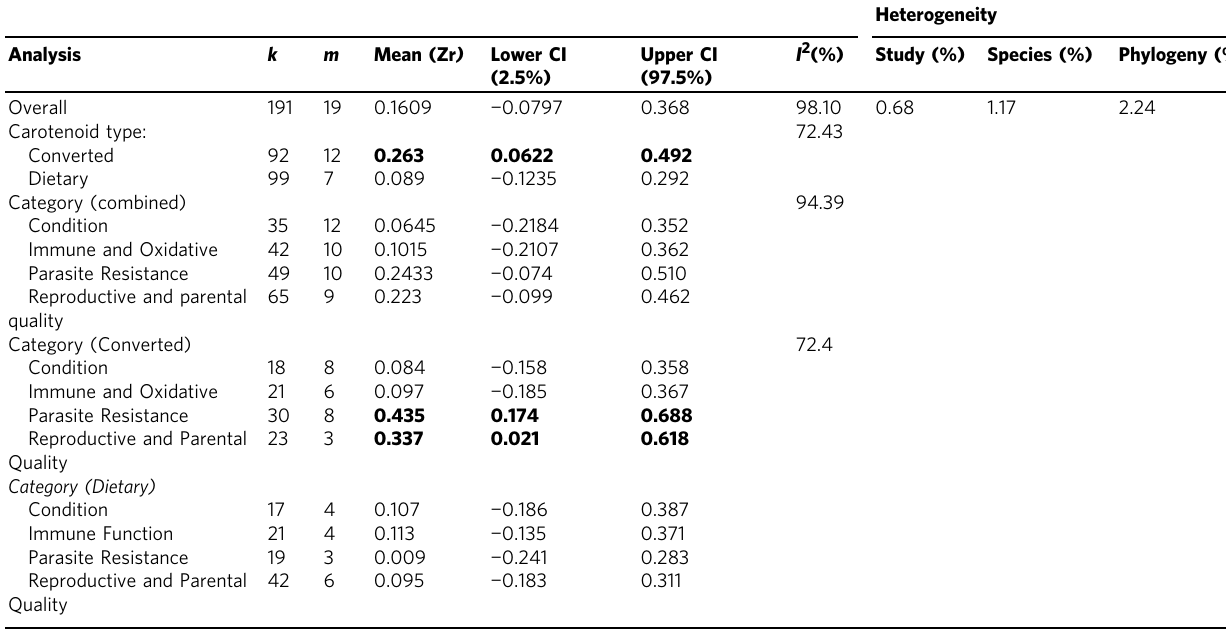
Table 1 Results from mixed-effects multi-level phylogenetic meta-analyses that assume effect sizes within studies are correlated ( r =